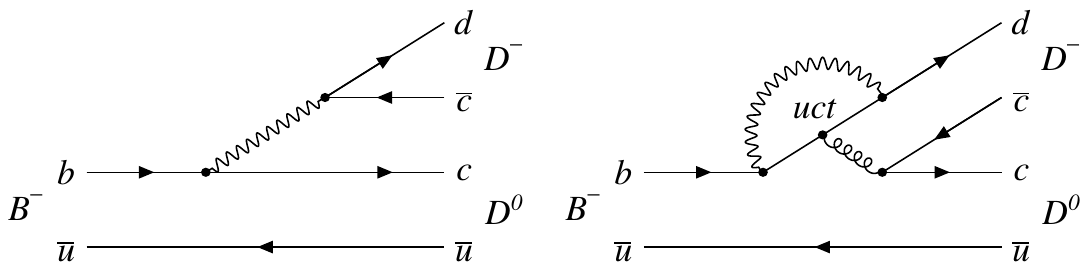
Figure 1 . Illustration of (left) tree diagram and (right) loop diagram contributions to the decay B (cid:0) ! D (cid:0) D 0 . Similar diagrams, with the d replaced by s , apply to the decay B (cid:0) ! D (cid:0) precise measurements of the CP asymmetry in B (cid:0) ! D (cid:0) D 0 decays are from the Belle and BaBar experiments, A CP = (0 (cid:6) 8 (cid:6) 2)% [16] and A CP = ( (cid:0) 13 (cid:6) 14 (cid:6) 2)% [17], respectively, where the (cid:12)rst uncertainties are statistical and the second systematic. The CP asymmetry in B (cid:0) ! D (cid:0) D 0 decays has not been measured before. s This paper describes a measurement of the CP asymmetry in B (cid:0) ! D (cid:0) B (cid:0) ! D (cid:0) D 0 decays, using pp collision data corresponding to an integrated luminosity of 3.0 fb (cid:0) 1 , of which 1.0 fb (cid:0) 1 was taken in 2011 at a centre-of-mass energy of